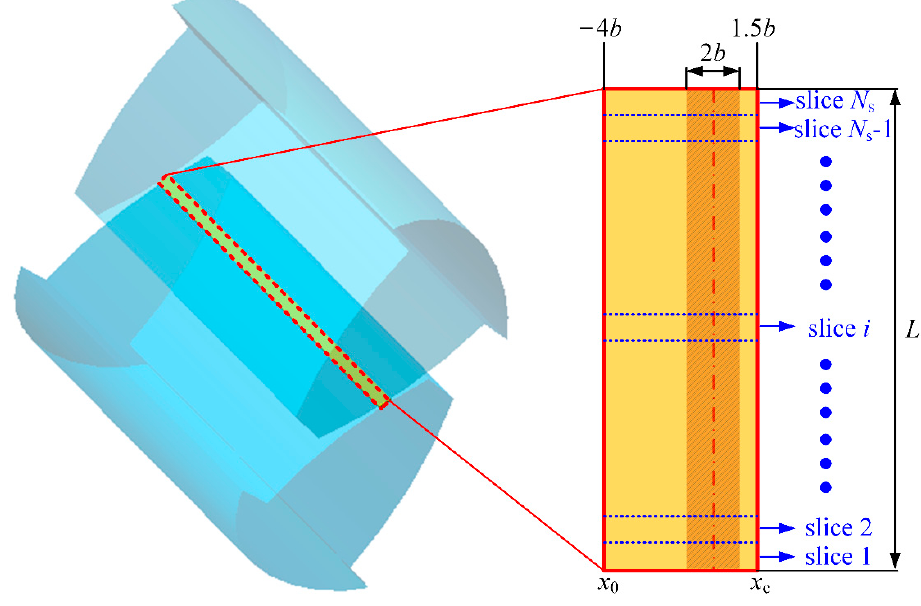
Figure 5. Schematic of the sliced EHL model.